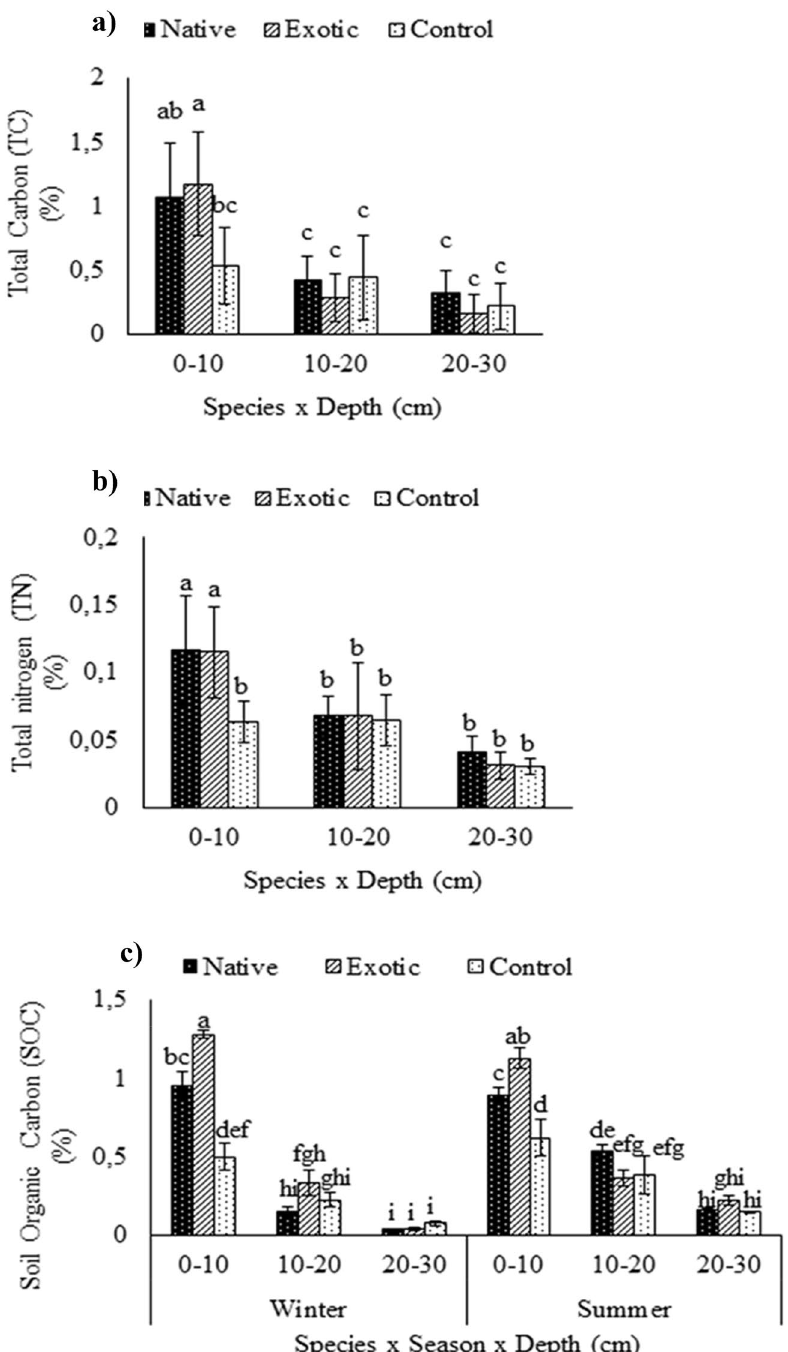
Figure 5. ( a ) The interactive effects of species × soil depth on total carbon, ( b ) Total nitrogen and ( c ) The interactive effects of species × season × soil depth on soil organic carbon under native Tamarix , extotic Tamarix and the control at three soil depths (0–10, 10–20, 20–30 cm) in two season at Leeu River, Western Cape. Means followed by different letters are significantly different from each other, with separation of means performed using Turkey’s test HSD. Bars indicate standard